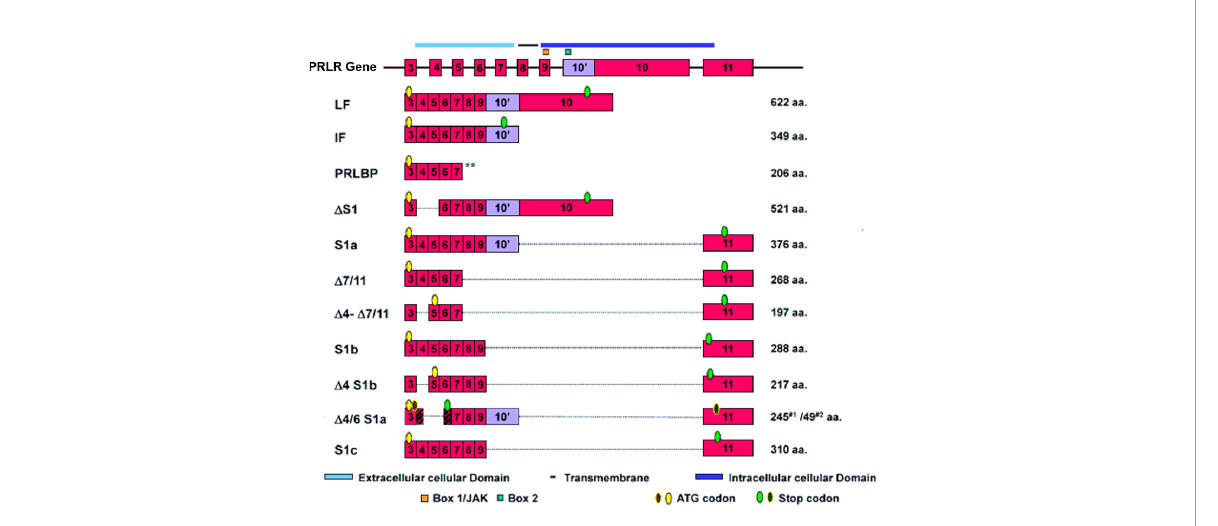
FIGURE 2 Schematic representation of human PRLR isoforms generated by alternative splicing [adapted from reference (27)] PRLR (prolactin receptor) Atlas Genet Cytogenet. ** indicates soluble form of